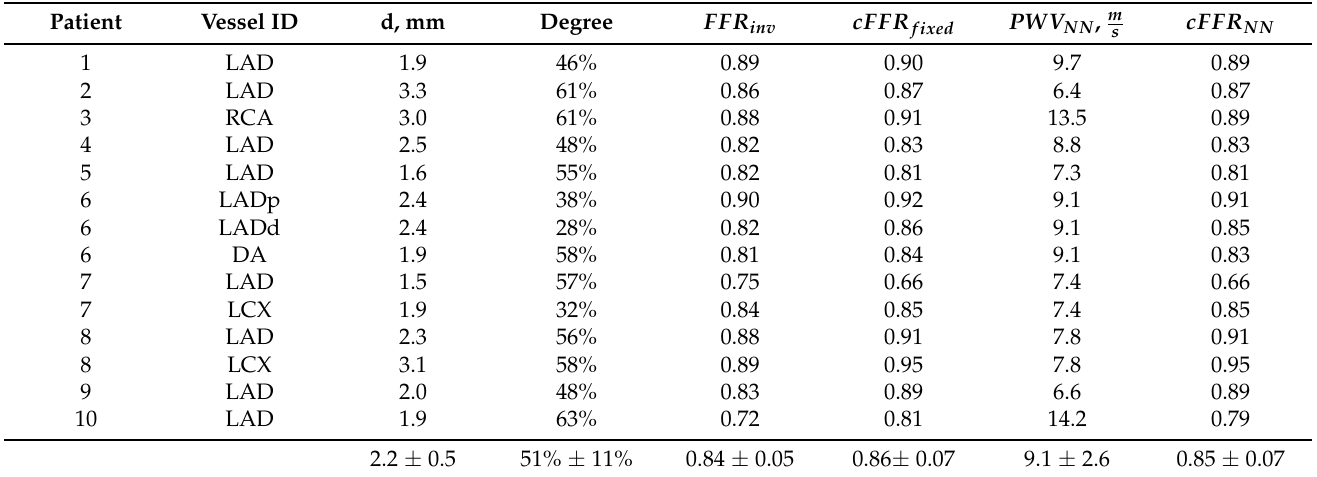
Table 4. FFR values for average and personalized AoPWV. Vessel ID is the notation of the vessel with stenosis, d is the diameter of the non-stenosed part of a vessel, Degree is the percentage diameter in stenosis, FFR inv is the invasively measured FFR value, cFFR fixed is the calculated FFR with fixed AoPWV for each case ( AoPWV = 7.5 m/s), PWV NN is the AoPWV estimated from the neural network and cFFR NN is the calculated FFR with AoPWV estimated from the neural network. The bottom of the table contains the mean values ± standard